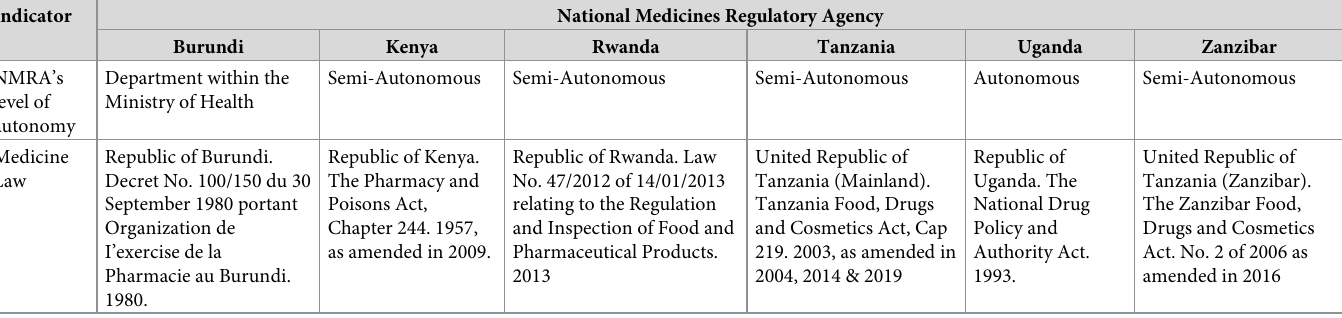
Table 1. Level of NMRA autonomy in the EAC partner states between the years 2011 and 2015. Indicator